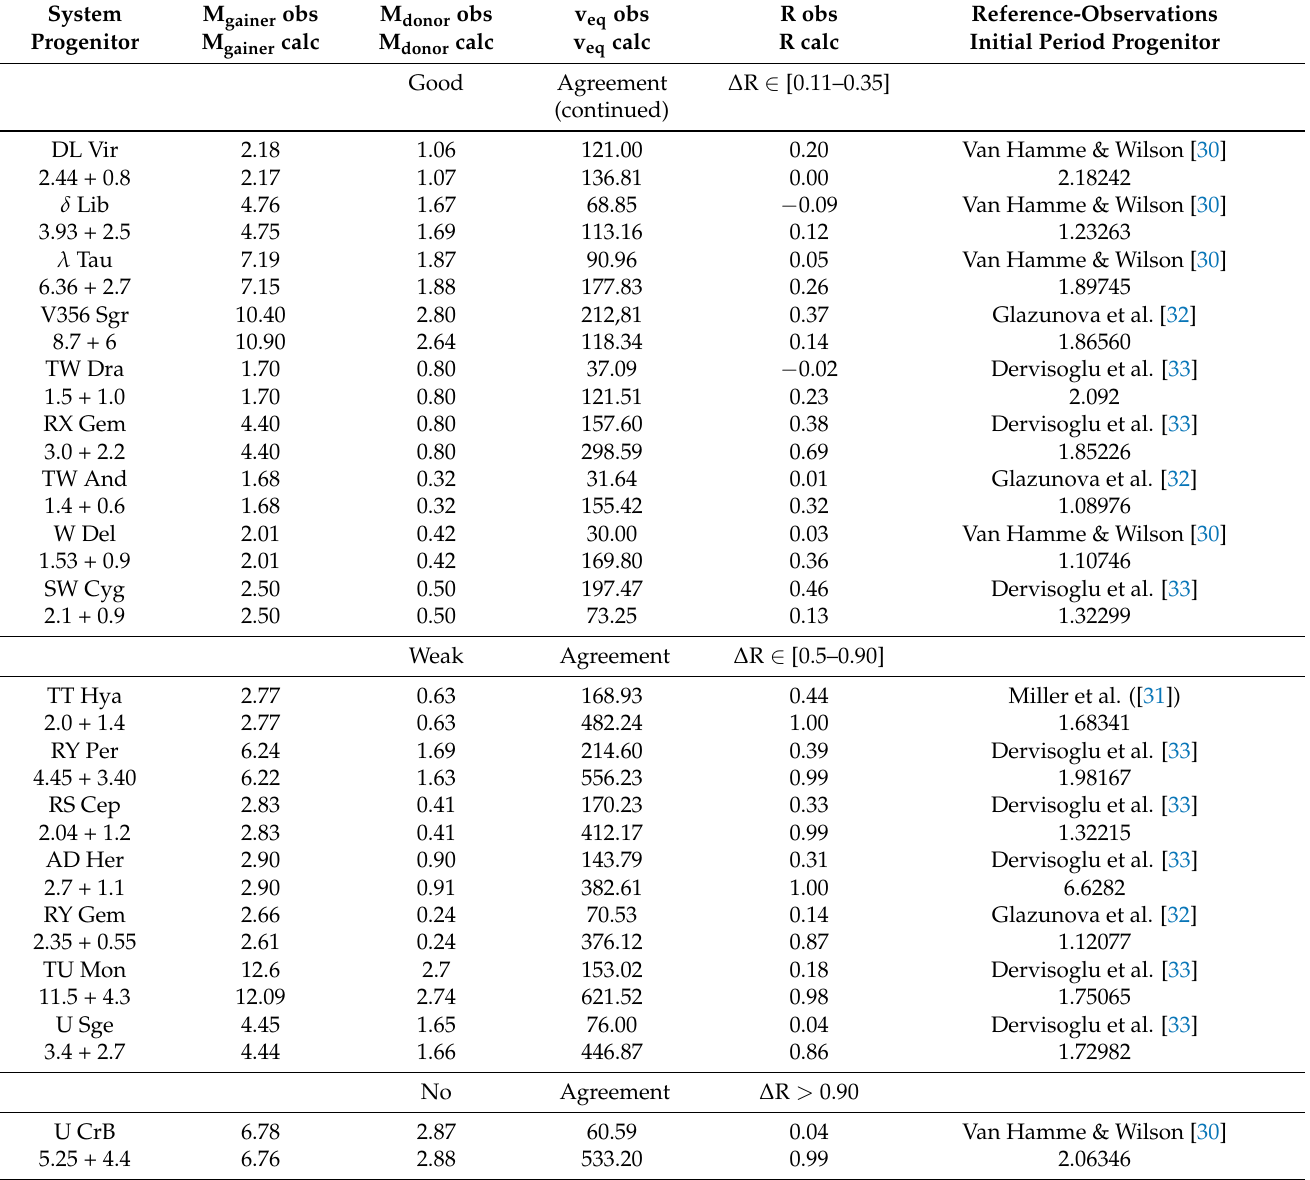
Table 2. Calculated equatorial velocities of gainers fitting observations less good than in Table 1. The masses for V356 Sgr are from ([37]). There are no systems found with ∆ R ∈